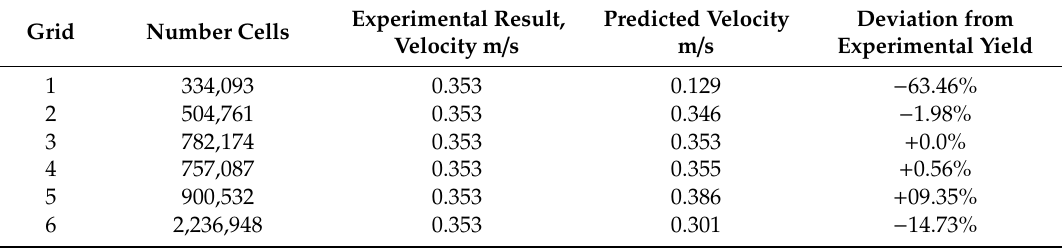
Table 1. Grid sizes were tested for buoyancy airflow for a duct width of 15 cm and the resulting velocities compared to those measured from an experiment with the same duct width (i.e., 0.353 m / s). Experimental Grid Number Cells